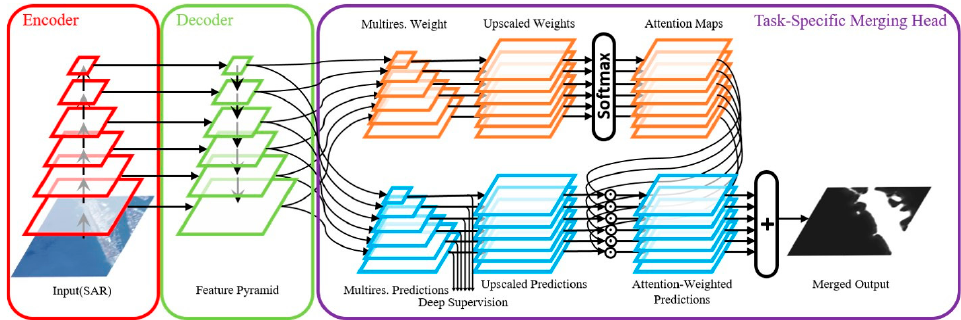
Figure 4. HED-Unet architecture with only the segmentation head [3]